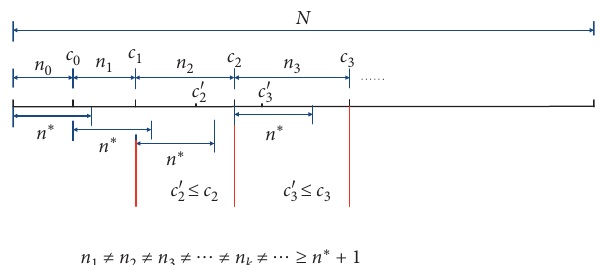
Figure 3: Gradual independent piecewise method sketch